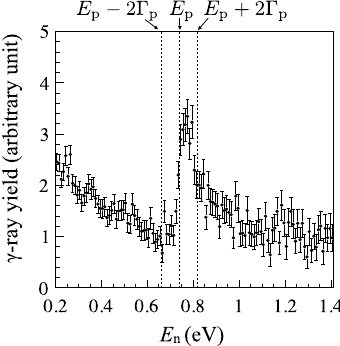
Figure 7. γ -ray yield as function of neutron energy of the p-wave resonance gated with the full absorption peak at 5161 keV at the 36 ◦ detectors. The dashed lines describe the regions to obtain N L and N H (see text).